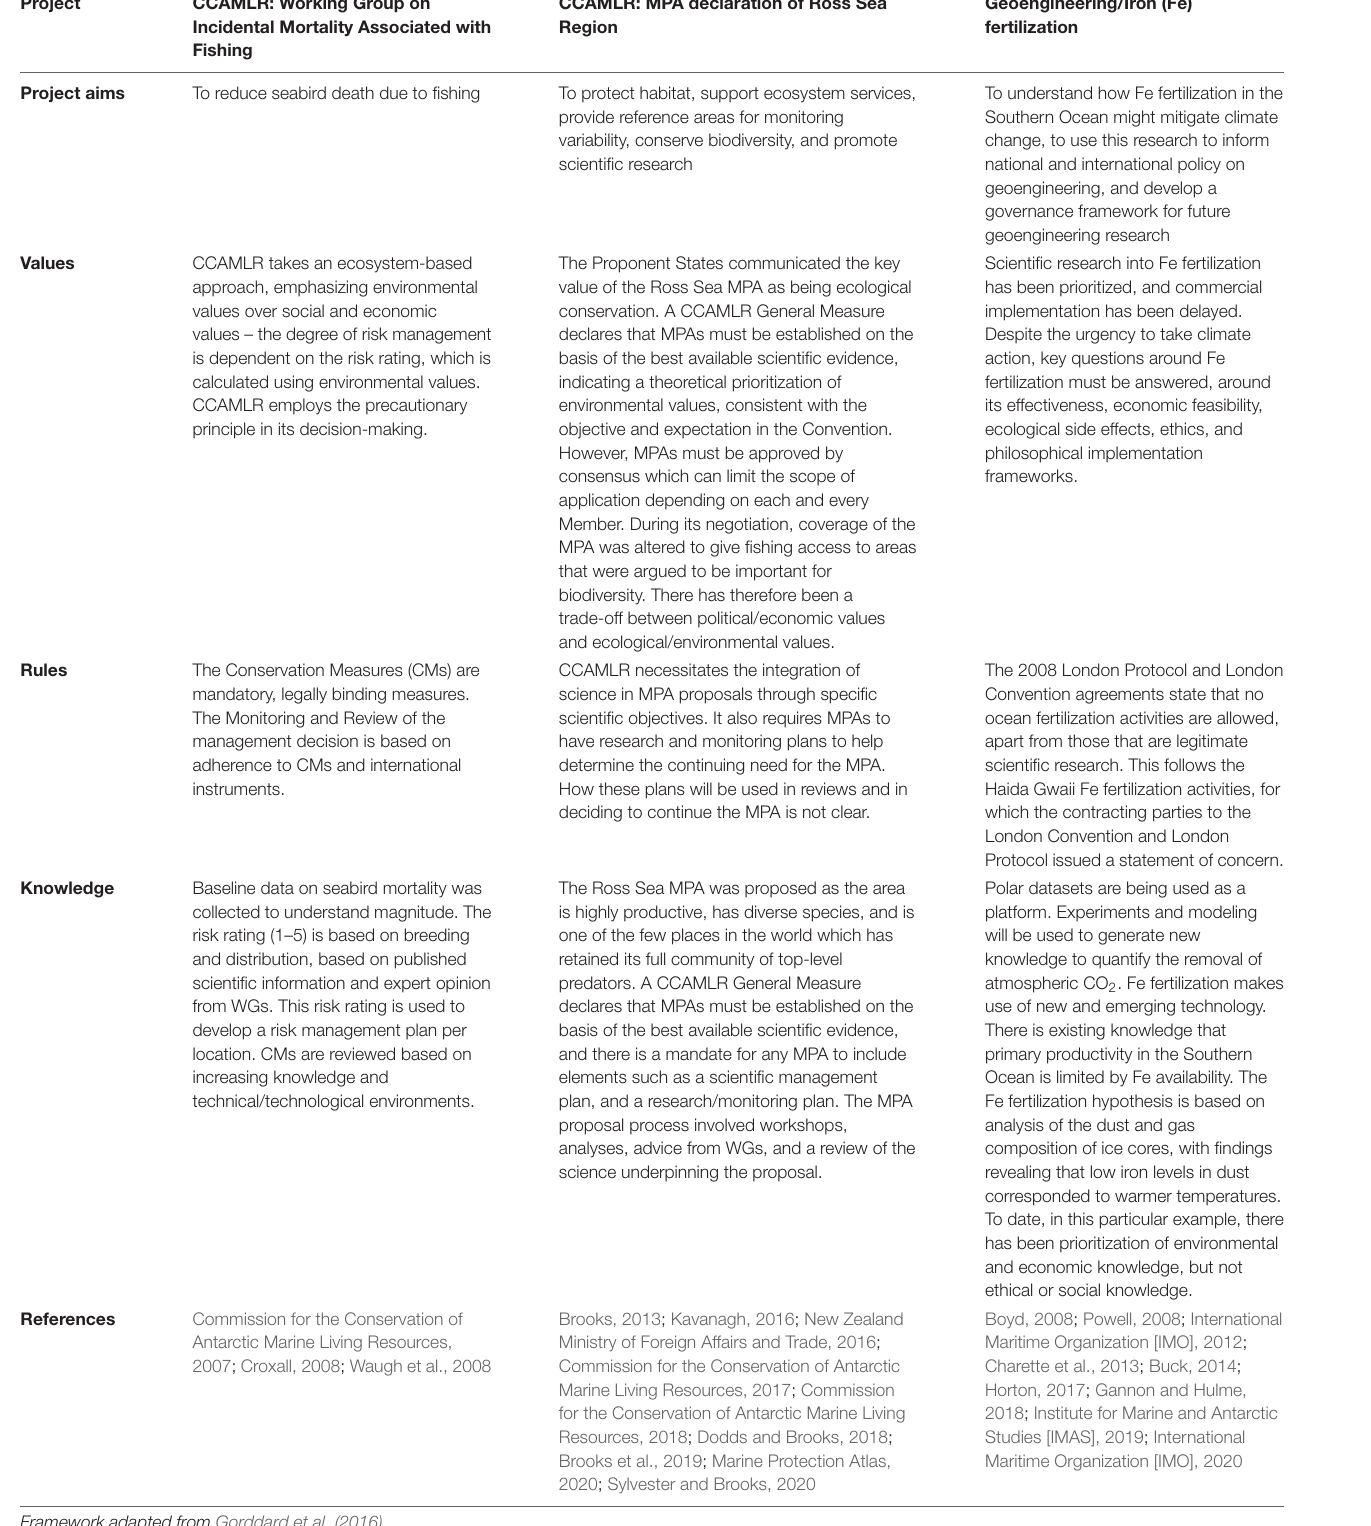
TABLE 4 | vrk analysis of three Southern Ocean ecosystem management case